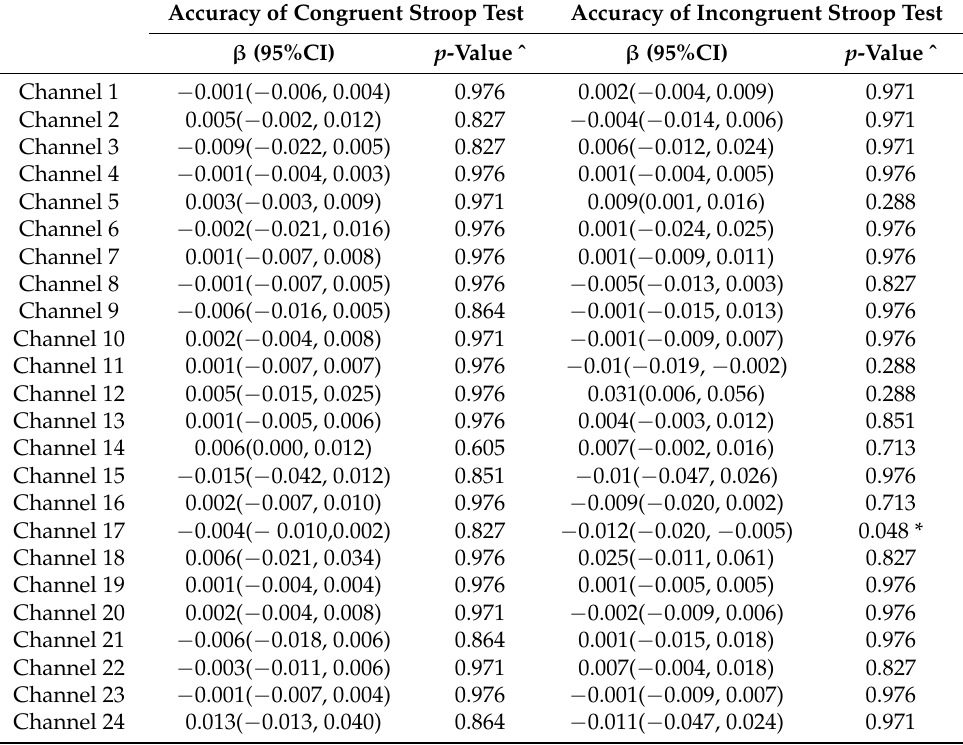
Table 2. The associations between the regional cortical changes in the concentrations of oxygenated hemoglobin (HbO) with congruent and incongruent Stroop test accuracy. Accuracy of Congruent Stroop Test Accuracy of Incongruent Stroop Test β (95%CI) p -Value ˆ β (95%CI) p -Value ˆ Channel